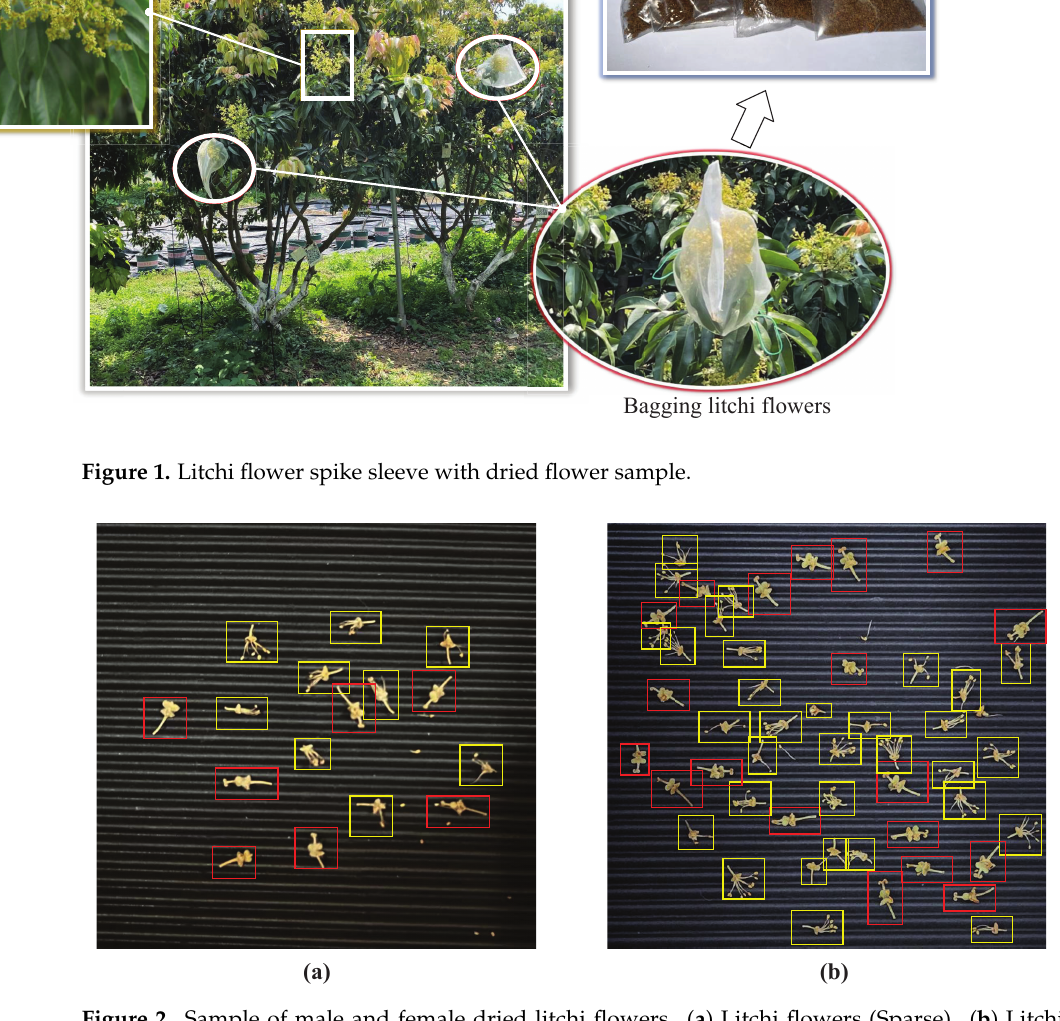
Figure 2. Sample of male and female dried litchi flowers. ( a ) Litchi flowers (Sparse). ( b ) Litchi flowers